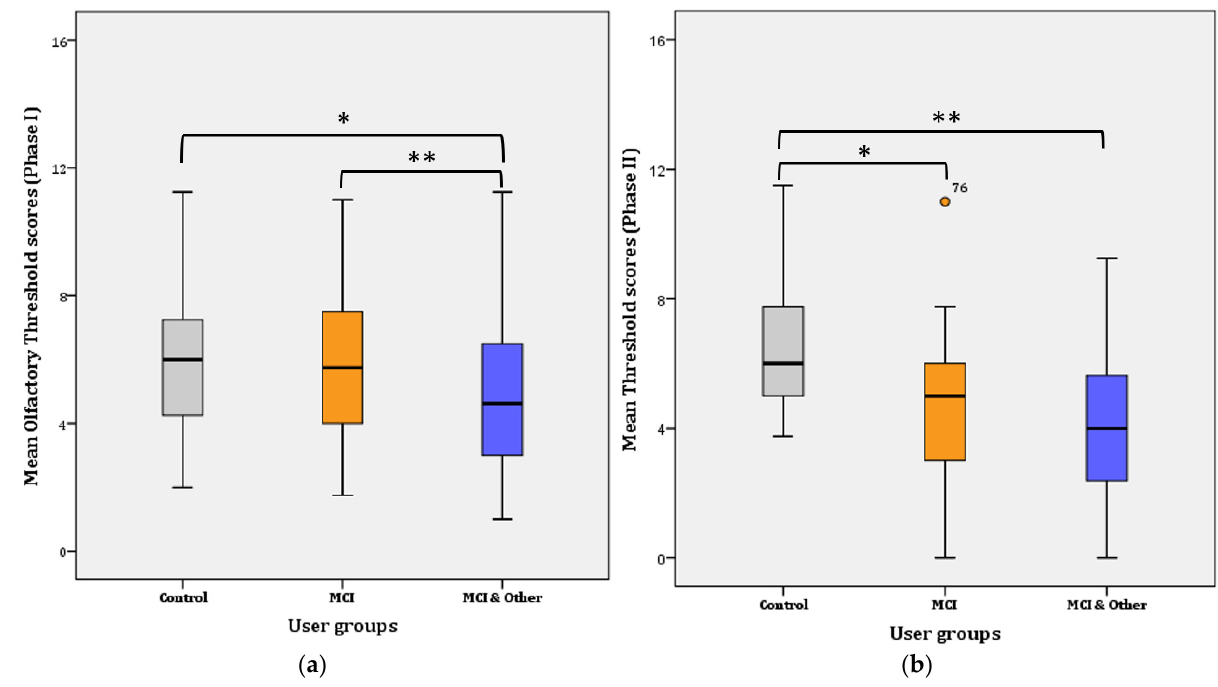
Figure 2. Mean Threshold scores per user group: ( a ) for Phase I; * for Control–MCI, p = 0.014, ** for Control–MCI & Other, p < 0.001. ( b ) for Phase II; *for Control–MCI, p < 0.001, ** for Control–MCI & Other, p < 0.001.